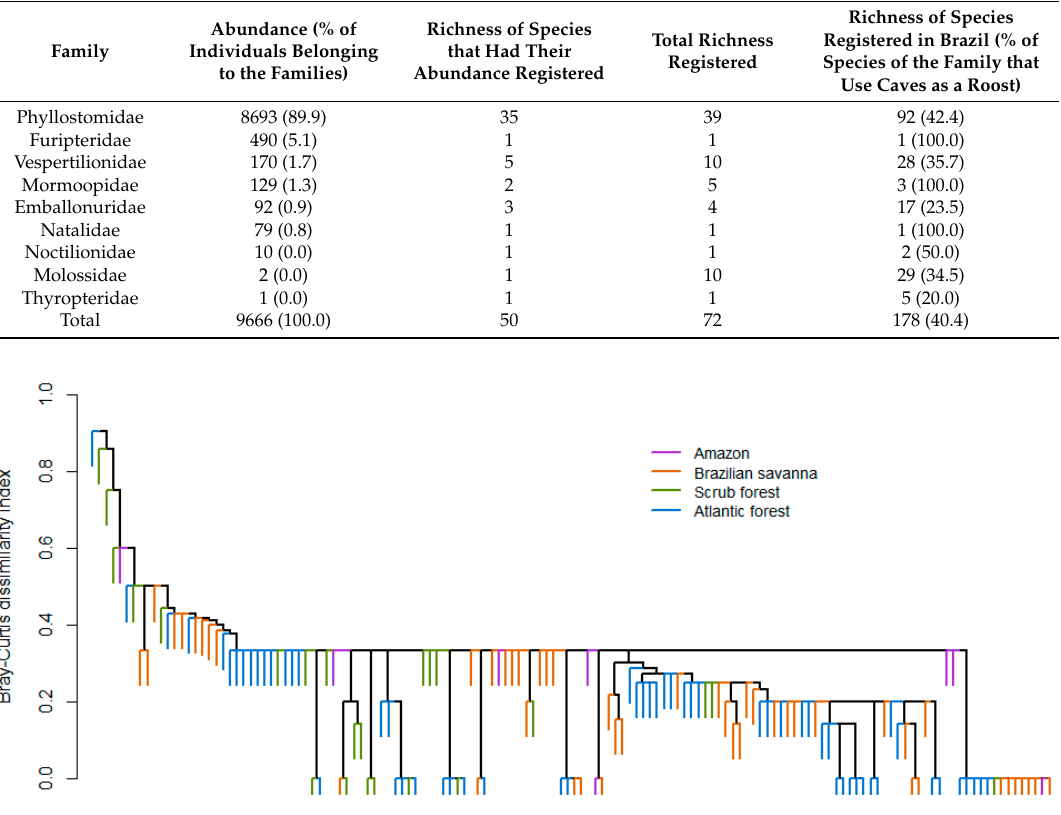
Figure 2. Assemblage composition of cave-dwelling bats according to Brazilian biomes.